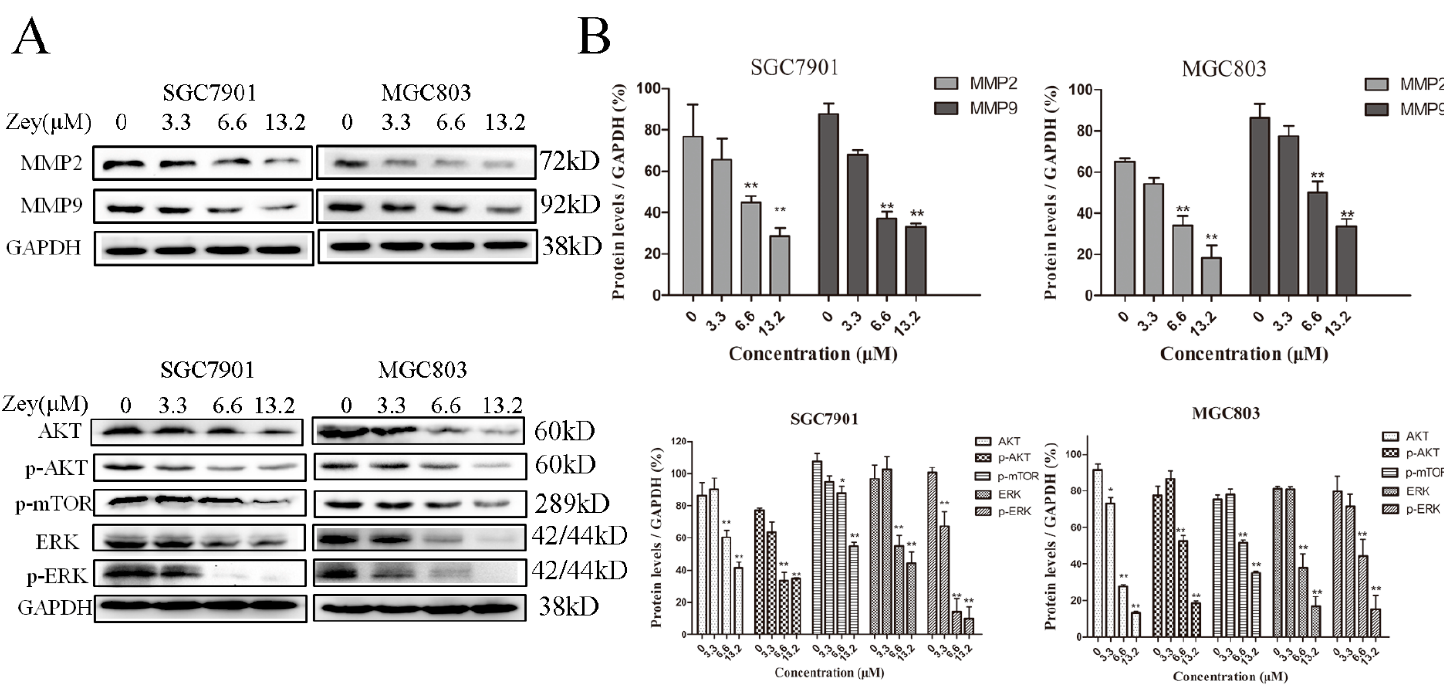
Figure 5. Zey attenuates AKT/matrix metalloproteinase 2 (MMP2)/MMP9, and ERK pathways in SGC7901 and MGC803 cells. ( A ) Immunoblot analyses of AKT, phosphorylated (p) ‐ AKT, MMP ‐ 2, MMP ‐ 9, p ‐ mTOR, ERK, and p ‐ ERK in Zey ‐ treated SGC7901 and MGC803 cells. ( B ) Quantitative analysis of protein levels. GAPDH was used to confirm equal protein loading. The data represented the means ± SD for triplicate determinations. * p < 0.05 and ** p < 0.01 vs. control cells.